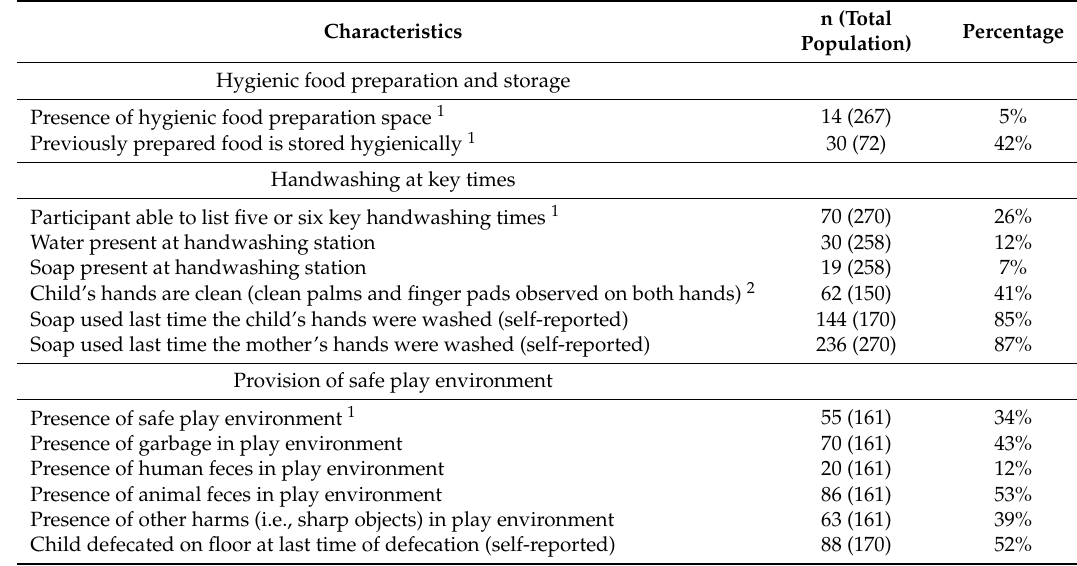
Table 3. Key hygiene behaviors of interest by population used for exploratory factor analysis (EFA) and confirmatory factor analysis